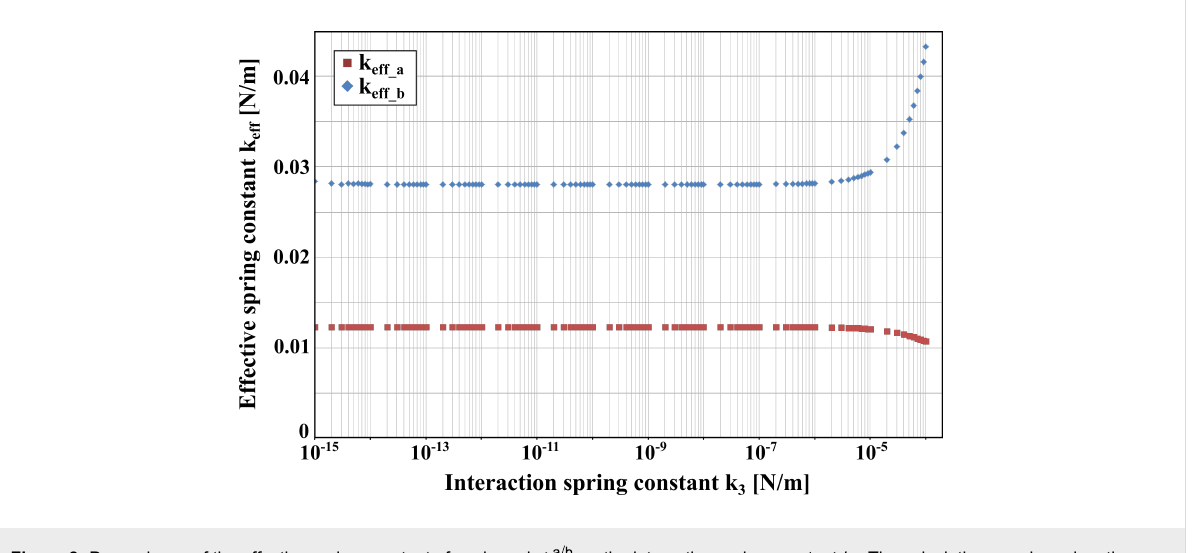
Figure 8: Dependence of the effective spring constant of each peak on the interaction spring constant k 3 . The calculations are based on the properties of the system given in Table